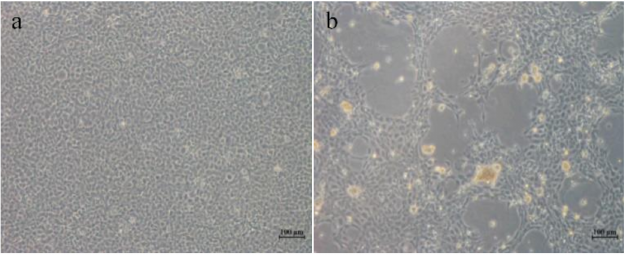
Figure 1. Cytopathic effect (CPE) induced by healthy grass carp reovirus (HGCRV) in a grass carp ovary (GCO) cell line. ( a ) Uninfected GCO cells. ( b ) CPE in GCO cells at 72 h after infection. CPE, cytopathic effect; HGCRV, healthy grass carp reovirus; GCO, grass carp